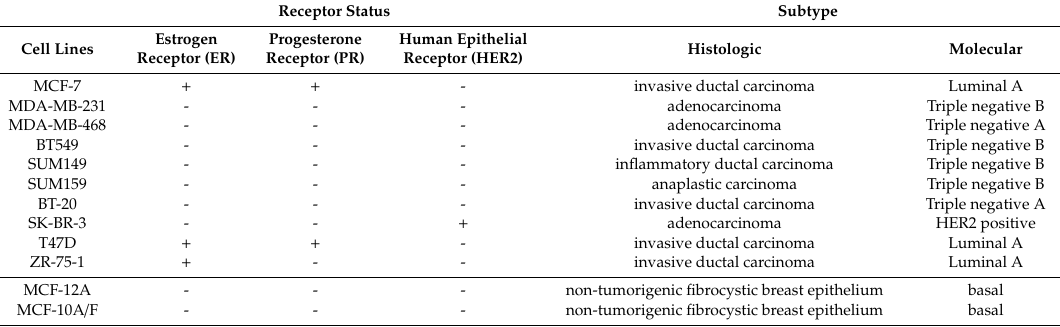
Table 3. Molecular data of breast cancer cell lines in comparison to normal breast cell